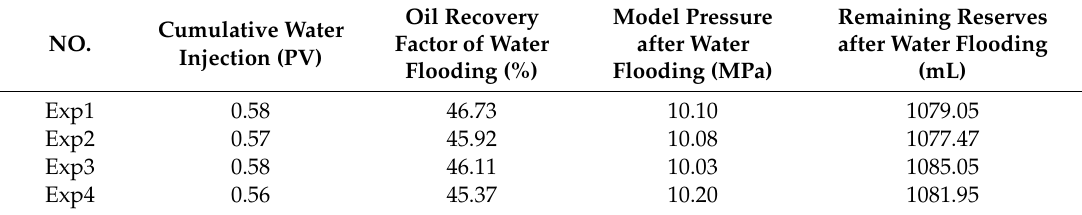
Table 5. Production data comparison of water flooding in different experiments.